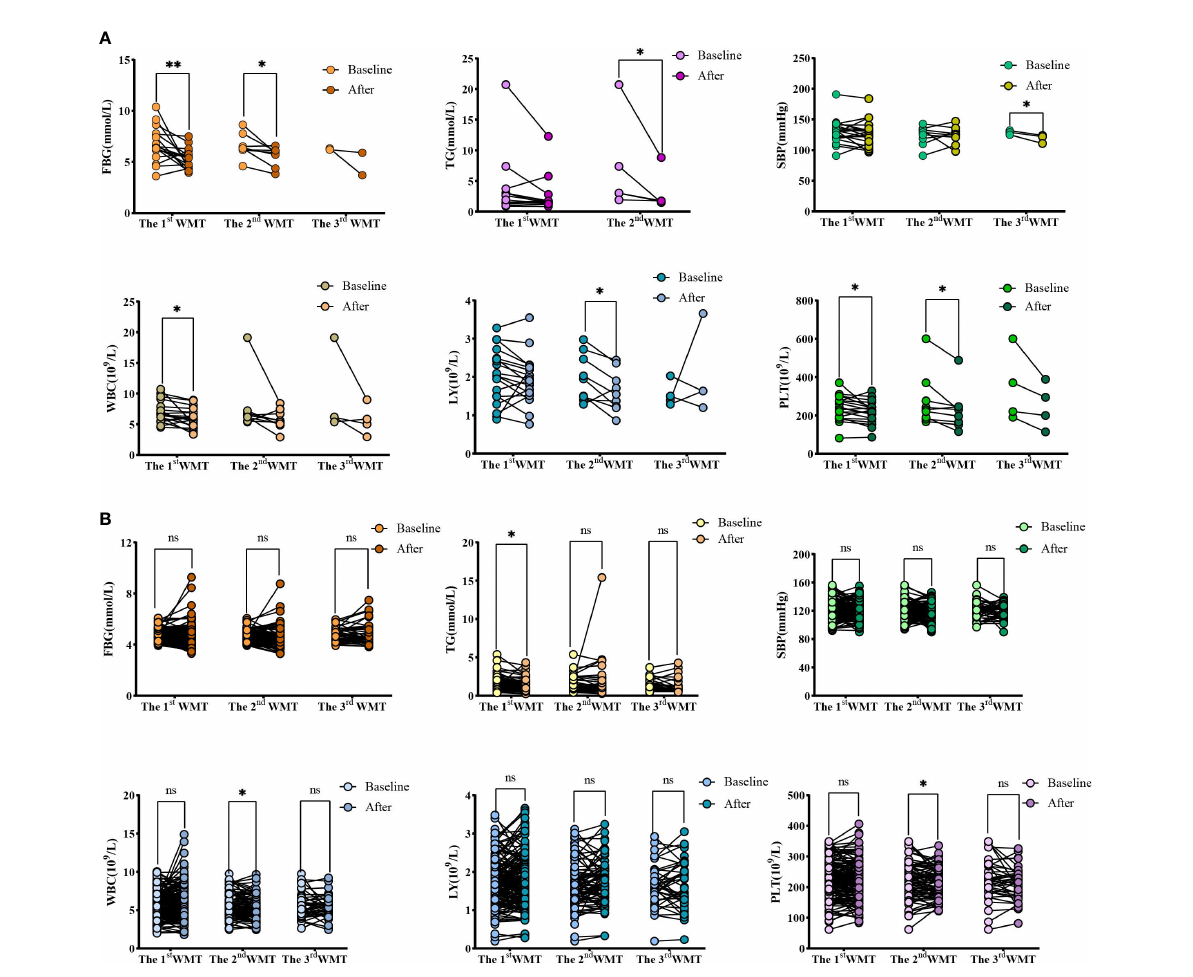
FIGURE 2 Changes of FBG, TG, SBP, WBC, LY and PLT levels after 1-3 times of washing and transplanting. (A) Changes of FBG, TG, SBP, WBC, LY and PLT in high blood glucose group; (B) Changes of FBG, TG, SBP, WBC, LY and PLT in normal blood glucose group. FBG, Fasting blood glucose; TG, Triglyceride; SBP, Systolic blood pressure; WBC, White blood cell; LY, Lymphocyte; PLT, Platelet. * indicates p < 0.05 ** indicates p < 0.01; ns, not signi fi